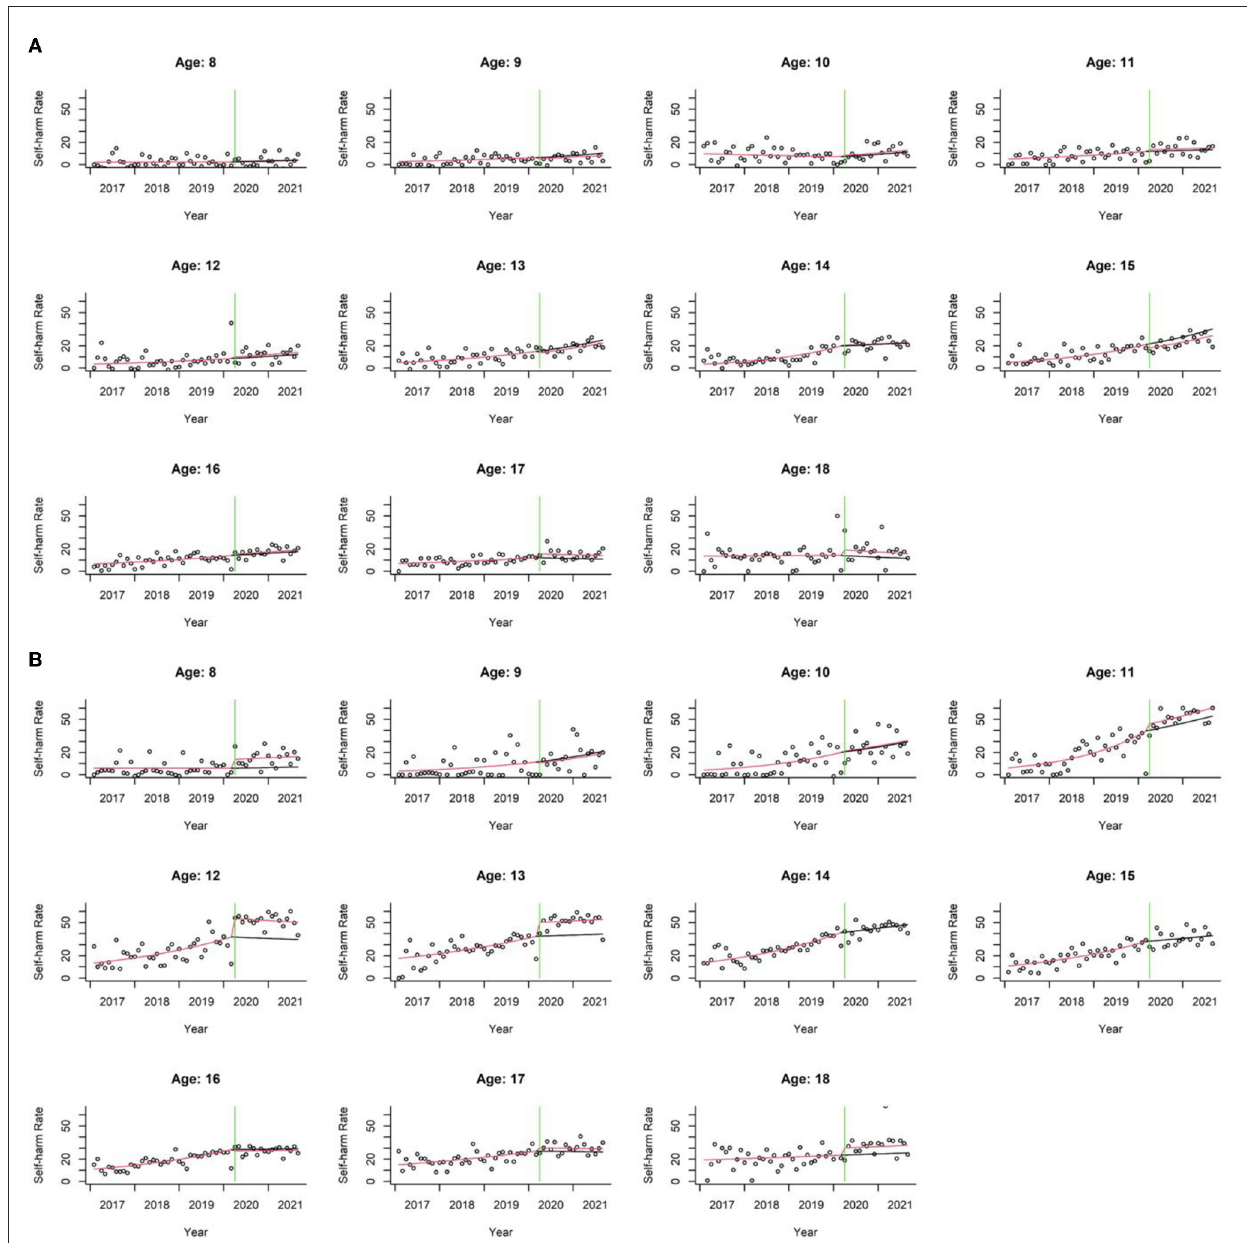
FIGURE3 Scatter plots of self-harm rates over time for male (A) and female patients (B) in each age group. Seasonality was removed from the observed and predicted data (see Supplementary Figure S1 for the scatter plots of data containing the seasonality). The dots represent the observed monthly self-harm rates. The red line represents the predicted self-harm rate according to the ITS model, while the black line represents the predicted self-harm rate if COVID-19 society-wide isolation (starting from the green line) did not